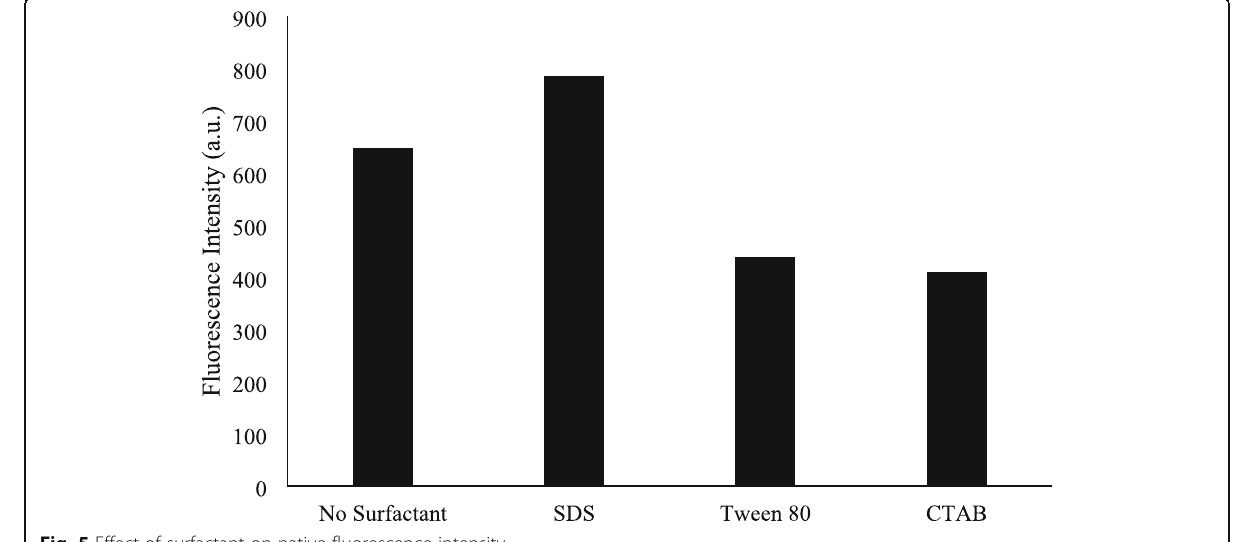
Fig. 5 Effect of surfactant on native fluorescence intensity